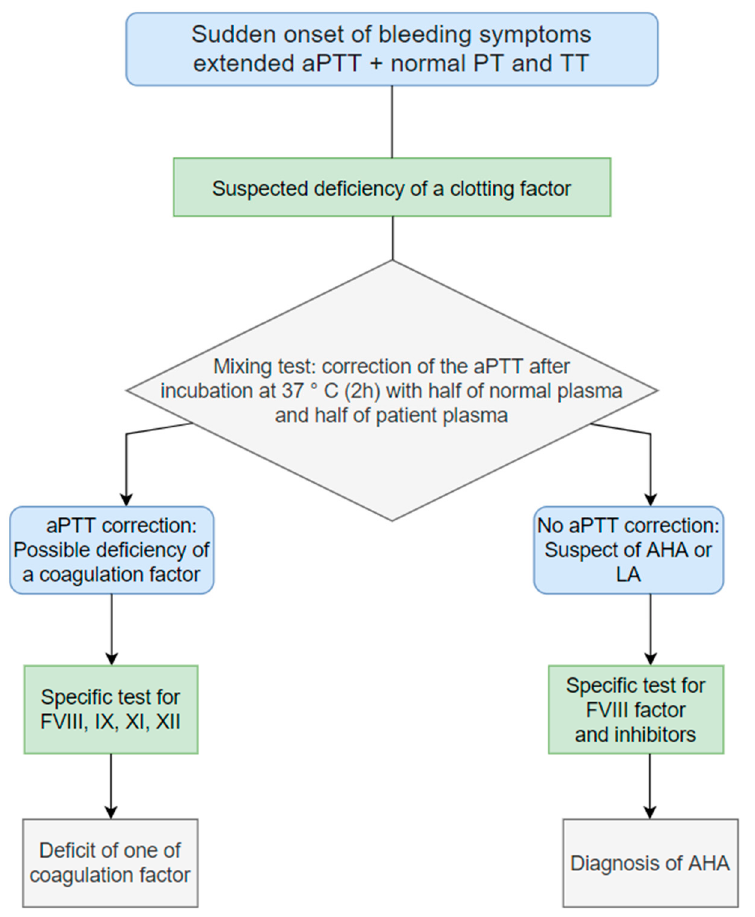
Figure 1. Flow chart for the diagnosis of AHA = acquired Hemophilia A. LA = lupus anticoagulant; PT = prothrombin time; TT = thrombin time; aPTT = activated partial prothrombin time; FVIII = Coagulation factor VII, IX =Factor IX, XI = Factor XI, XII = Factor XII.